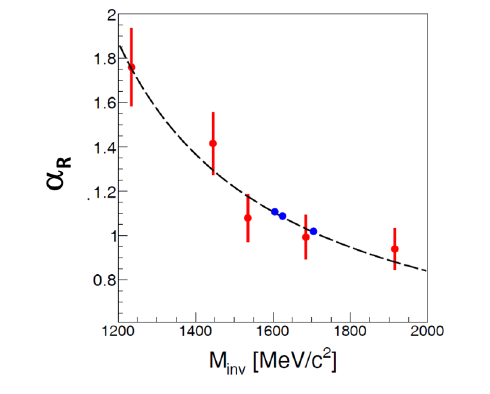
Figure 6. Dependency of the constant α R used for the parametrization of the four-momentum transfer dependence of the cross section (Eq. 1) on the resonance mass M R from fits to the data of 1 π production analysis [10].